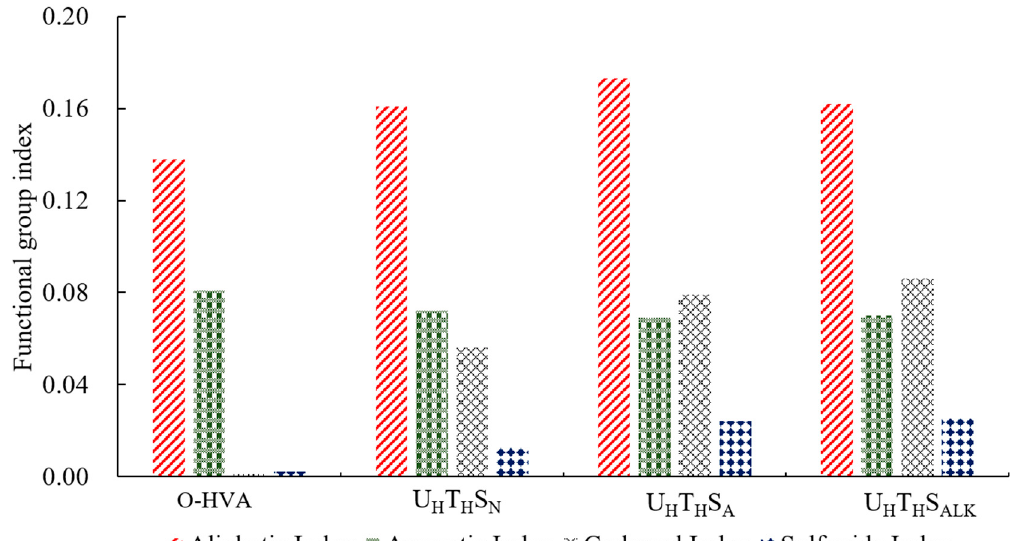
Figure 7. Variation of spectrum of different asphalt samples under different water environment.